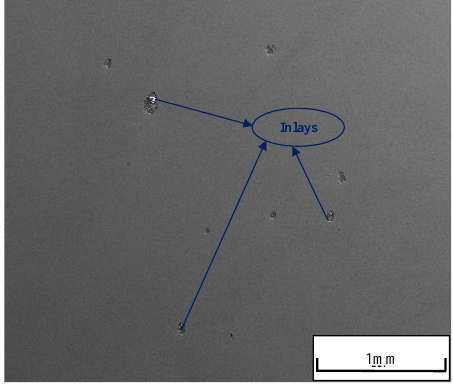
Figure 11. Macroscopic distribution of inclusions in general porosity steel.